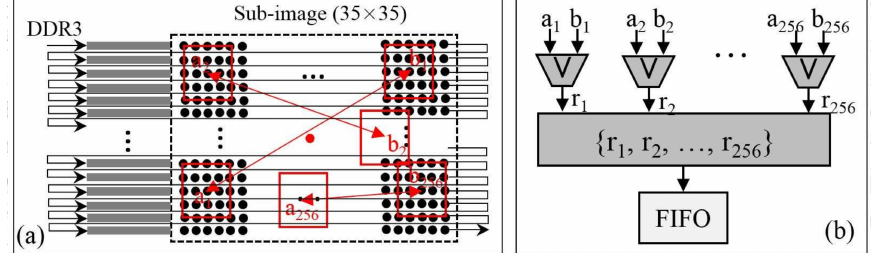
Figure 8. BRIEF descriptor generation module, ( a ) line buffers; ( b ) 256 binary